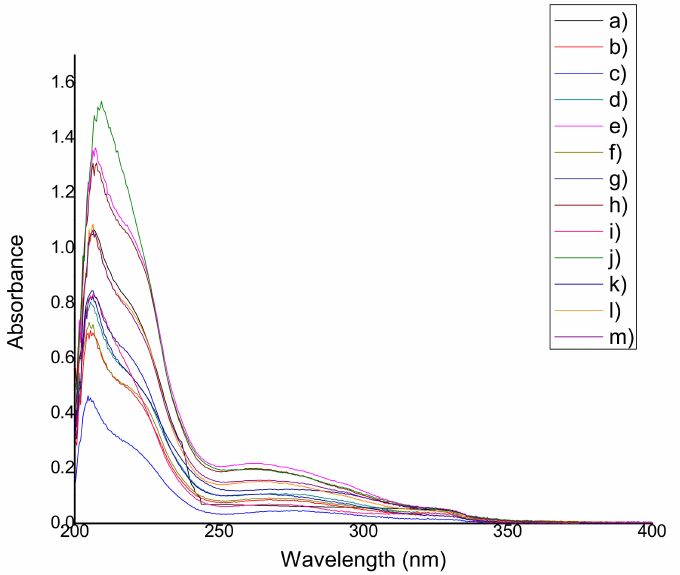
Figure 5. UV spectrum of ( a ) QS2; ( b ) QSA0.5; ( c ) QSA2; ( d ) QSA5; ( e ) QSAm0.5; ( f ) QSAm2; ( g ) QSAm5;